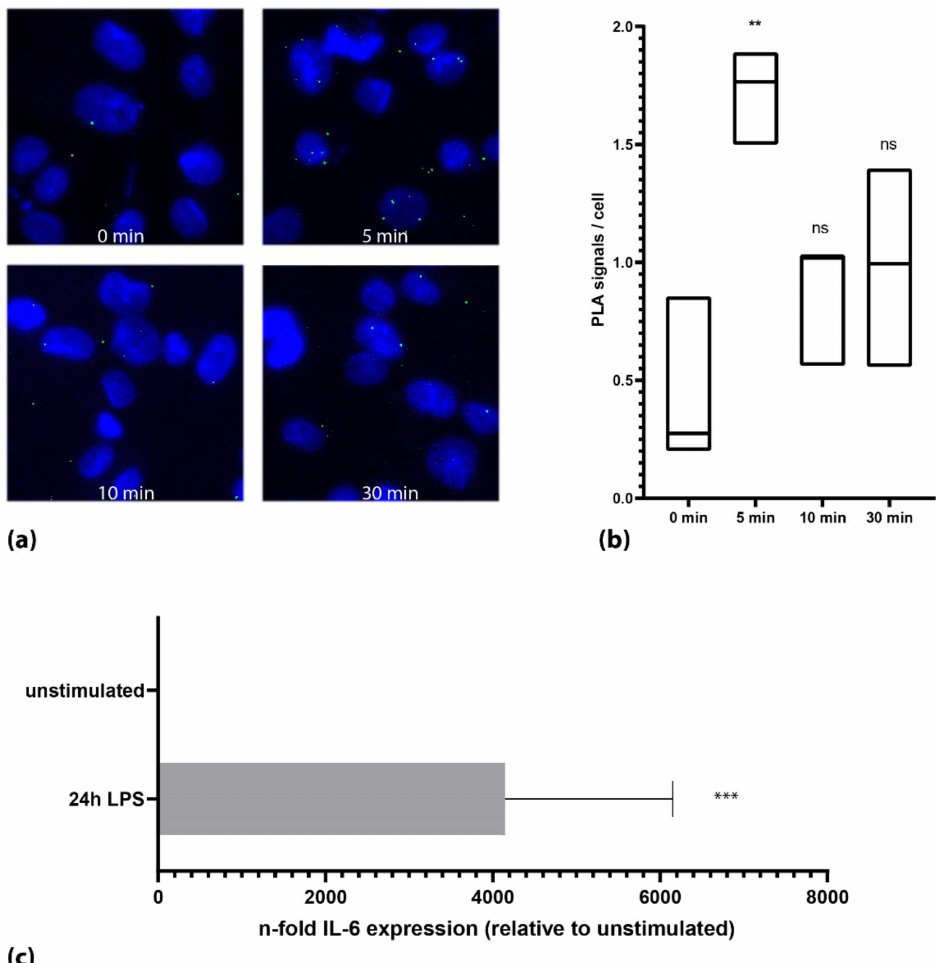
Figure 2. Activation of TLR4 on endogenous expression levels. ( a ) Microscopic images of the THP-1 cells of one representative experiment. Cells showed a transient increase in TLR-4 phosphorylation after 4 min. ( b ) Quantification of all experiments ( n = 3) together (Mann–Whitney U test). Black lines in the box plots represent the median. ( c ) Stimulation of the THP-1 cells with LPS showed a strong increase in IL-6 after 24 h. (***: p < 0.001; **: p < 0.01, ns: not significant; p >